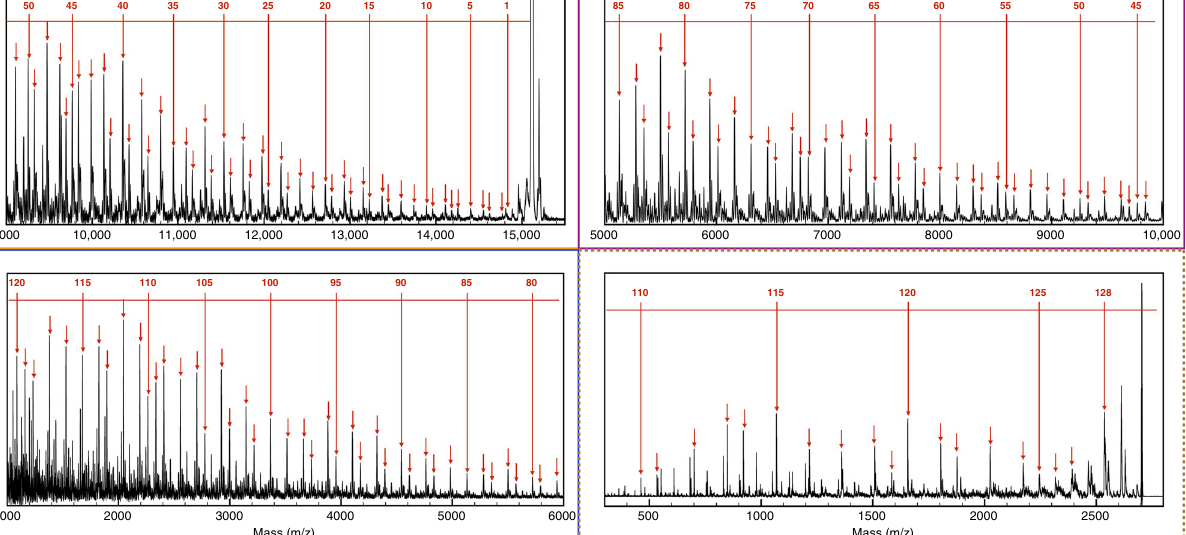
pore). The SEC was performed under a cycling mode until the coinciding peaks were separated. The desired fraction was collected using a fraction collector. Two prep-SEC systems ran in parallel, giving the maximum capacity of separation of 1g. MALDI-TOF and Tandem mass sequencing of PcL . Molecular weights of PcLs and their fragments were measured on a Bruker Ultra fl ex TOF/TOF mass spec- trometer equipped with a smartbeam 2 (Nd:YAG laser) at 2000 Hz (MALDI-MS) or 1000Hz (MALDI-MS/MS). For MALDI-MS analysis, the instrument was oper- ated in a positive re fl ector mode with voltage for ion source 1 (20kV), ion source 2 (17.65kV), lens (8.4kV), re fl ector 1 (21.2kV) and re fl ector 2 (10.65kV). Voltage for ion source 2, lens, and re fl ector 2 is raised up to 17.75kV, 8.8kV and 10.8kV depending on the molecular weight of a polymer. PAHs with molecular weight above 20kDa were analyzed in a positive linear mode with the voltage for ion source 1 (20kV), ion source 2 (18.8kV), and lens (8.0kV). External calibration was based on peptide and protein (ProteoMass Peptide/Protein MADLI-MS Calibration Kit (mass to charge ratio from 750 to 66000Da), Sigma). Tandem mass sequencing (MS/MS) was performed in positive re fl ector mode with acceleration voltages for ion source 1 (7.62kV), ion source 2 (6.8kV), lens (3.6kV), re fl ector 1 (29.5kV), re fl ector 2 (13.9kV), LIFT 1 (19.00kV), and LIFT 2 (2.85kV) using no gas option. The pre- cursor ion was used as internal calibration. For MALDI and MS/MS analysis, 2-(4-